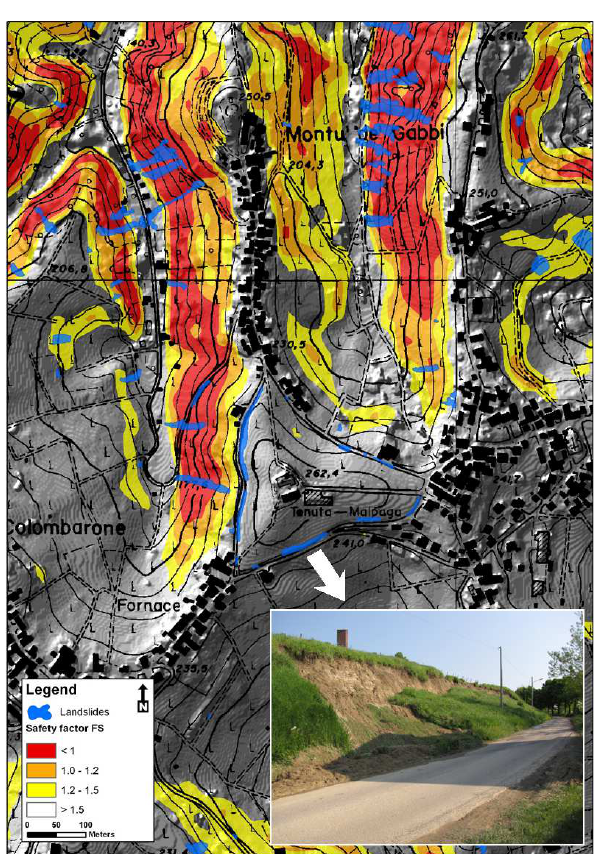
Fig. 9. Landslides of type c near “Tenuta Malpaga’’ in the munici- pality of Canneto